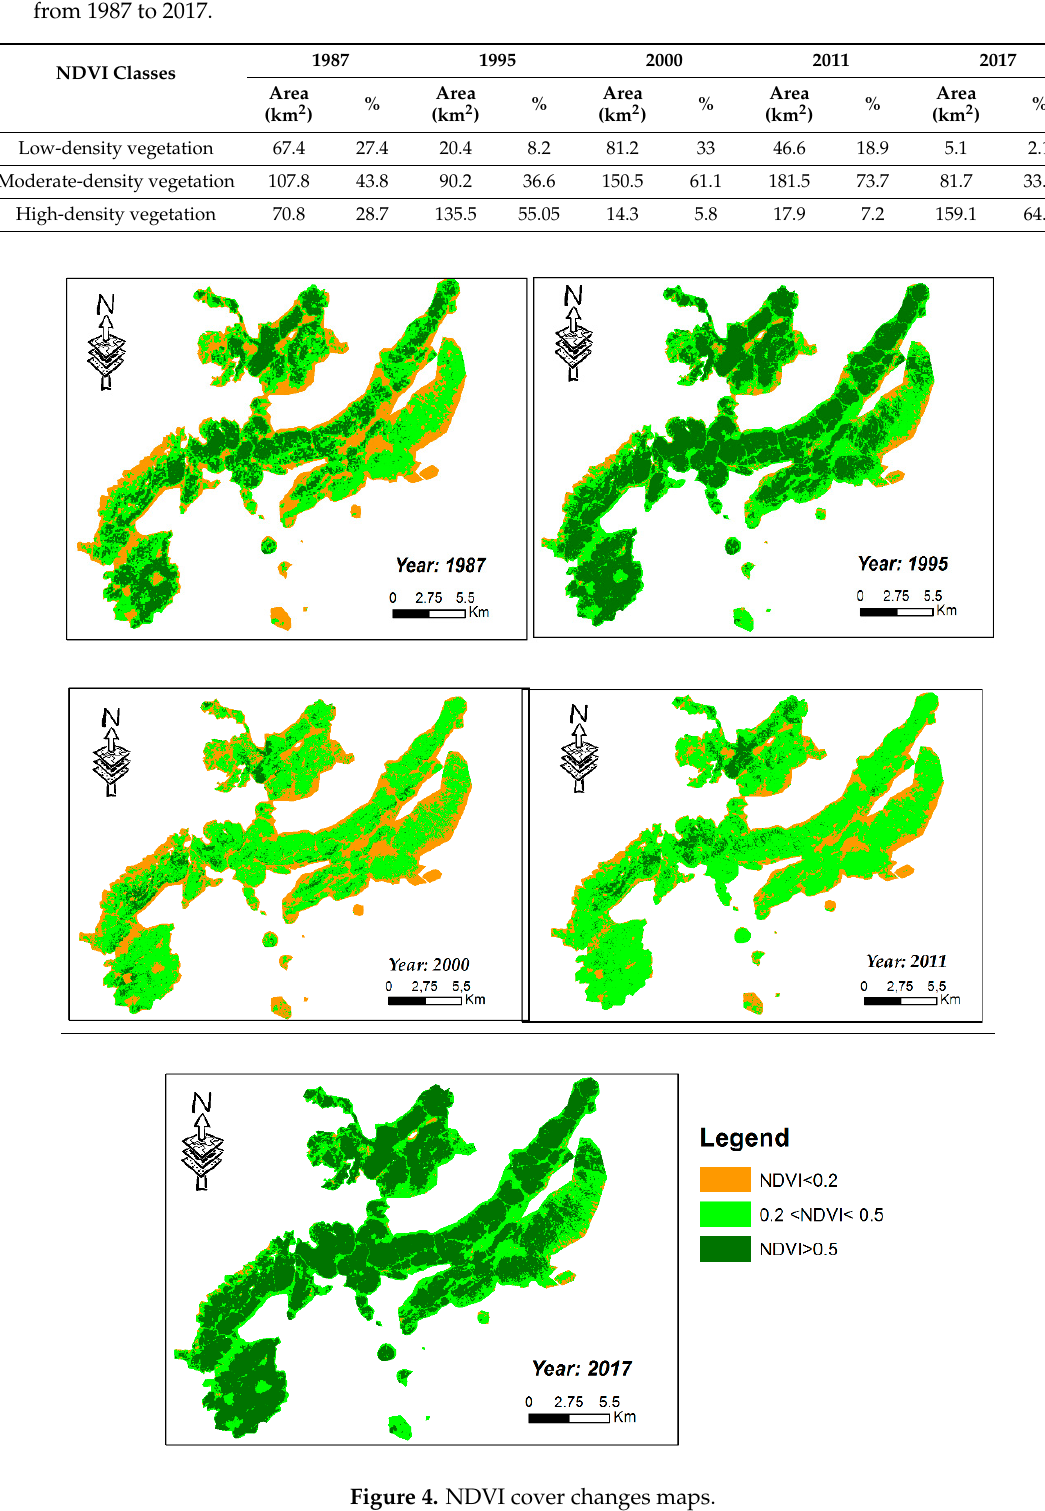
Figure 4. NDVI cover changes maps.